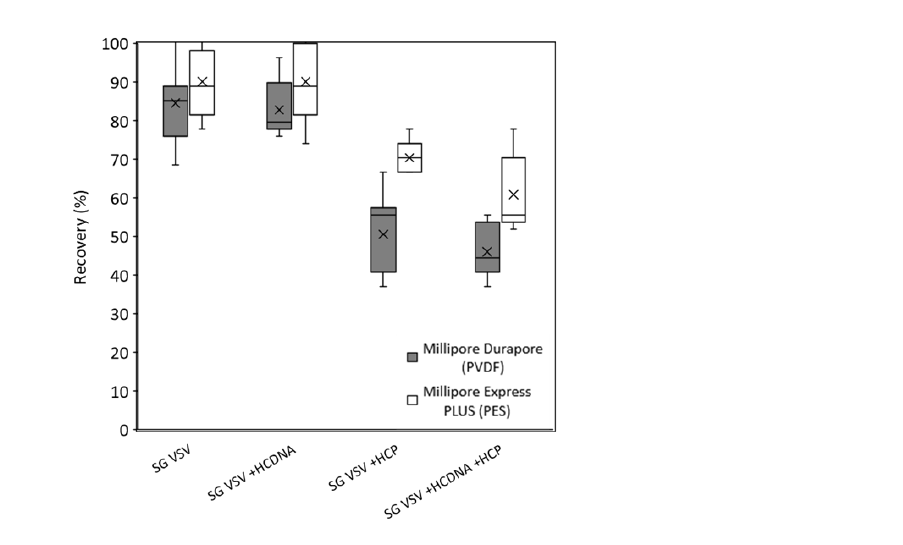
Figure 6. Box-and-whisker plot showing the recovery of vesicular stomatitis virus (VSV) after filtration, calculated as the ratio of filtrate to feed virus titer. Sucrose-gradient-purified VSV (SG VSV) was spiked with host cell protein (HCP), host cell DNA (HC DNA), or both host cell protein and DNA prior to filtration. Two membranes are compared, Millipore Durapore (PVDF) 0.22 µm and Millipore Express PLUS (PES) 0.22 µm. The boxes depict the interquartile range, the horizontal lines represent the median, and the cross marks represent the mean. The whiskers extending from the boxes show the maximum and minimum values measured.